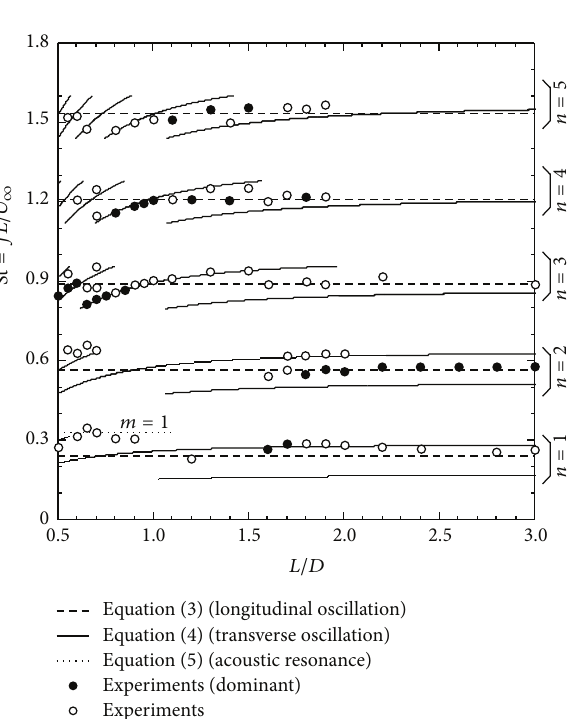
Figure 5: Plots of Strouhal number St versus 𝐿/𝐷 .